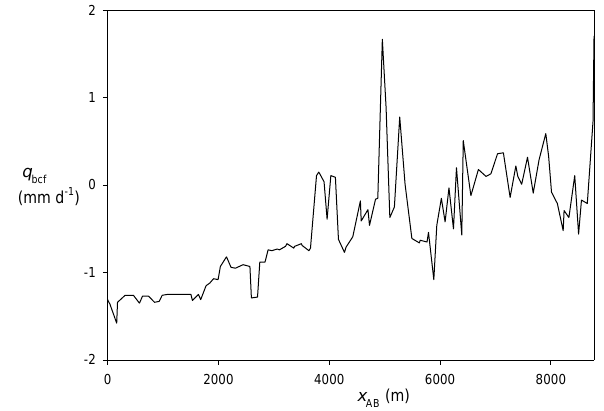
Fig. 8. Simulated net groundwater flux (Darcy flow, “BCF” in Figure 8. Simulated nett groundwater flux (Darcy flow, “BCF” in MODFLOW) for 2003 2 MODFLOW) for 2003 (time average), for the cross-section AB in (time average), for the cross-section AB in Fig. 5. 3 Fig. 5.